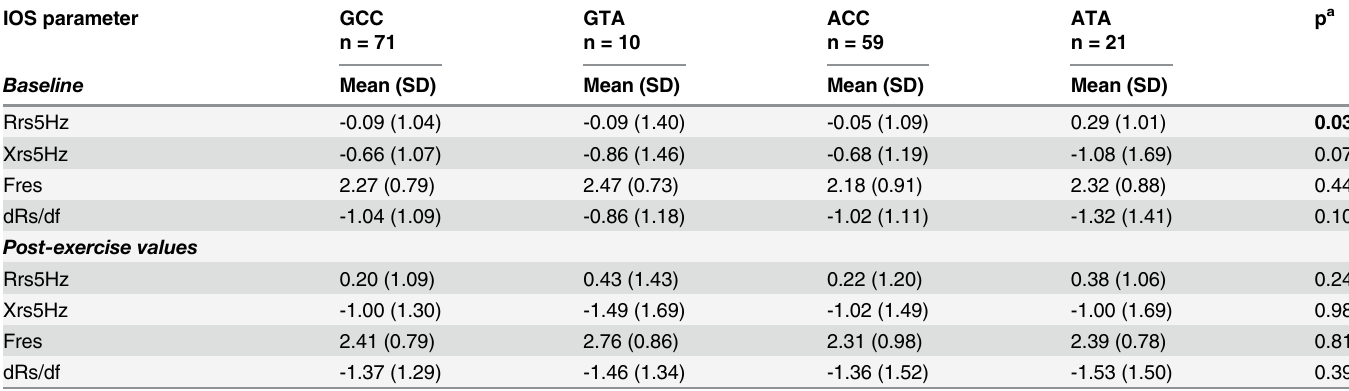
Table 7. Impulse oscillometry presented as Z-scores in relation to IL-10 rs1800896, rs1800871 and rs1800872 haplotype carriage in 99 pre-school- aged children after hospitalization for bronchiolitis in infancy. IOS